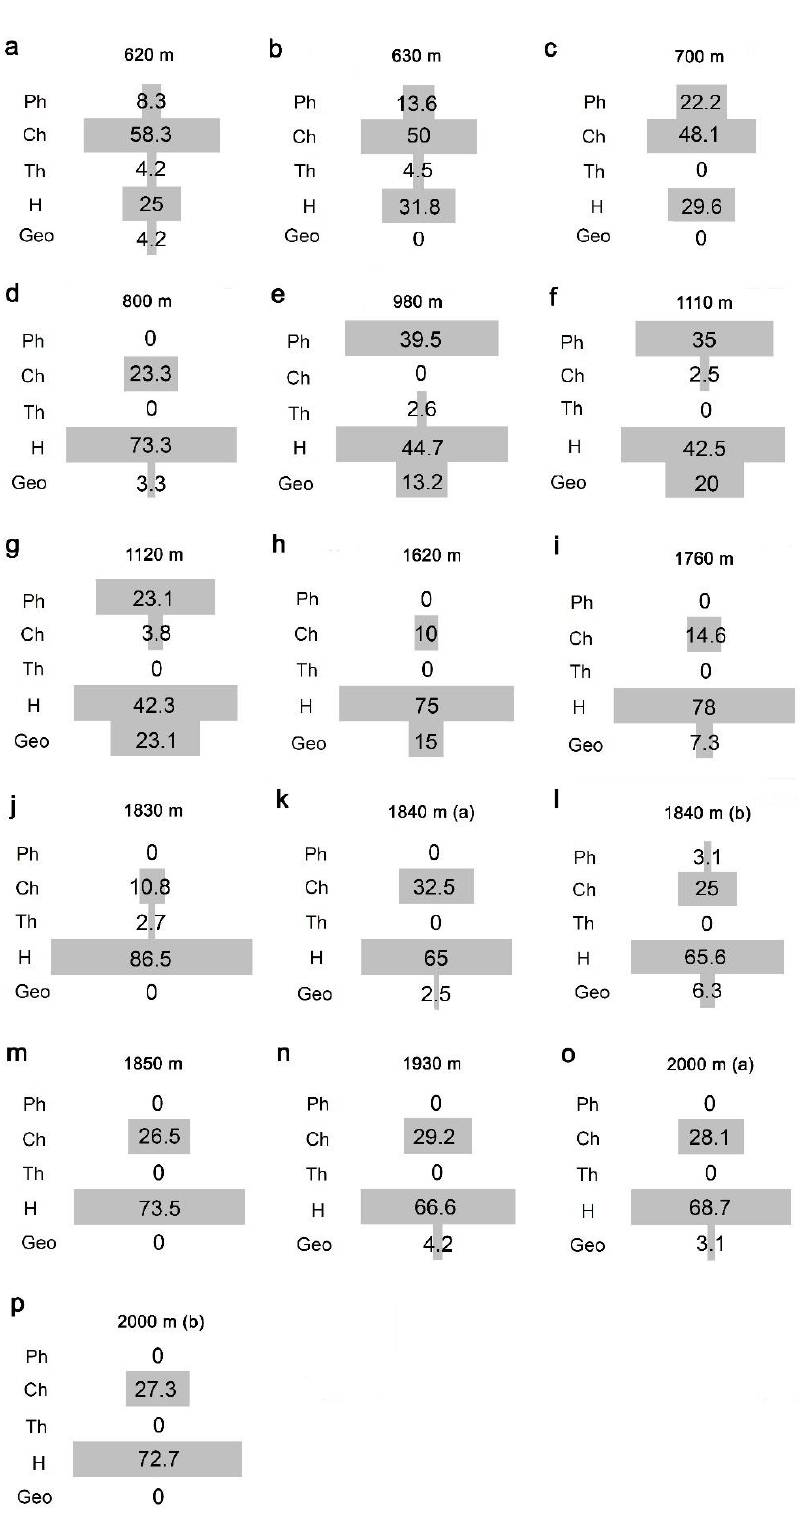
Figure 4. Life form composition of plant assemblages along an elevational gradient on a Central Apennine mountain (Mount Genzana): ( a ) 620 m, ( b ) 630 m, ( c ) 700 m, ( d ) 800 m, ( e ) 980 m, ( f ) 1110 m, ( g ) 1120 m, ( h ) 1630 m, ( i ) 1760 m, ( j ) 1830 m, ( k ) 1840 m, ( l ) 1840 m, ( m ) 1850 m, ( n ) 1930 m, ( o ) 2000 m, ( p ) 2000 m. Life forms: Ph = Phanerophytes, Ch = Chamaephytes, Th = Therophytes, H = Hemicryptophytes, Geo = Geophytes. Numbers indicate percentages. For 1840 m and 2000 m elevations, two relevés (conventionally indicated, in both cases, as a and b ) were available.